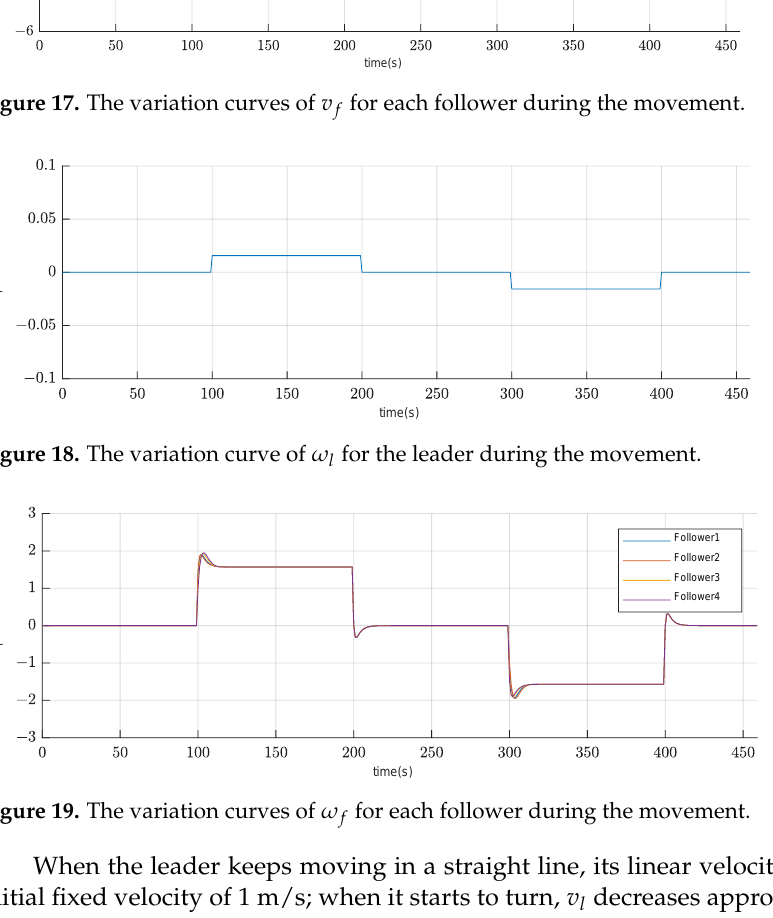
for each follower during the movement. 𝜔𝜔 𝑓𝑓